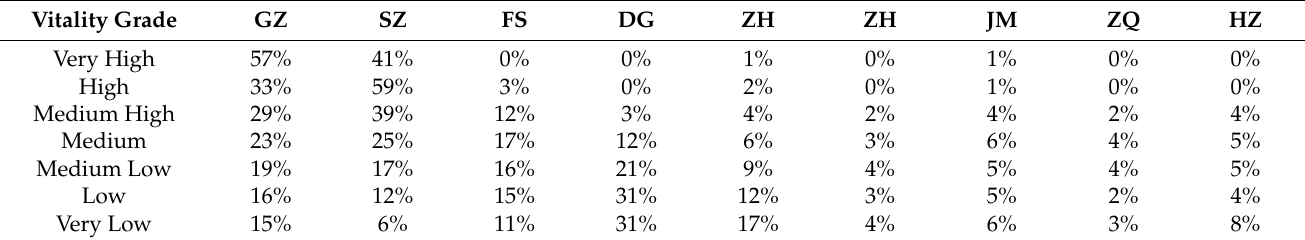
Table 5. The proportion of grids at different vitality levels in